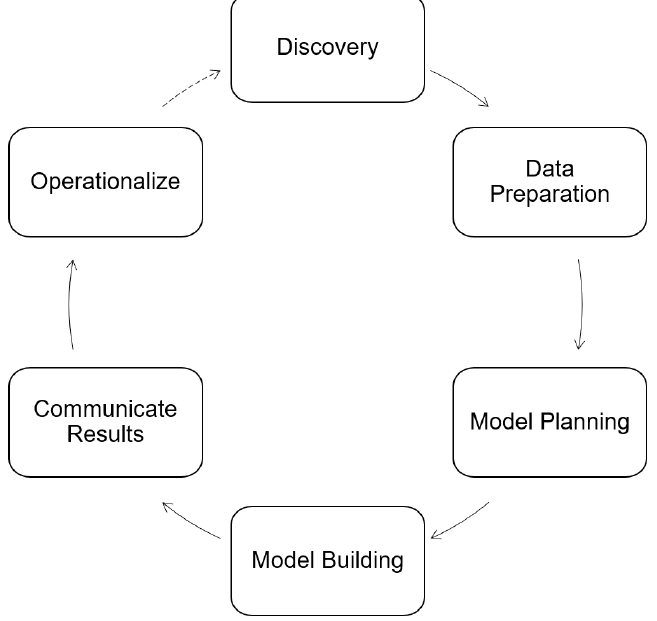
Figure 1. The data analytics life